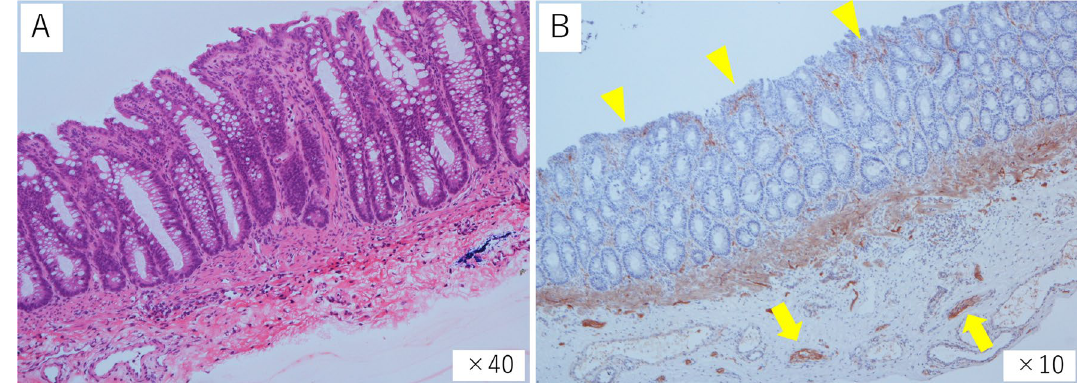
Fig. 3 Histological findings of the rectal mucosal biopsy on Day 63. Histology of the rectal mucosal biopsy showed A no ganglion cells in the rectal submucosa (hematoxylin and eosin) and B increased acetylcholinesterase-positive nerve fibers in the lamina propria (arrowheads) and immediately under the muscularis mucosa (arrows)